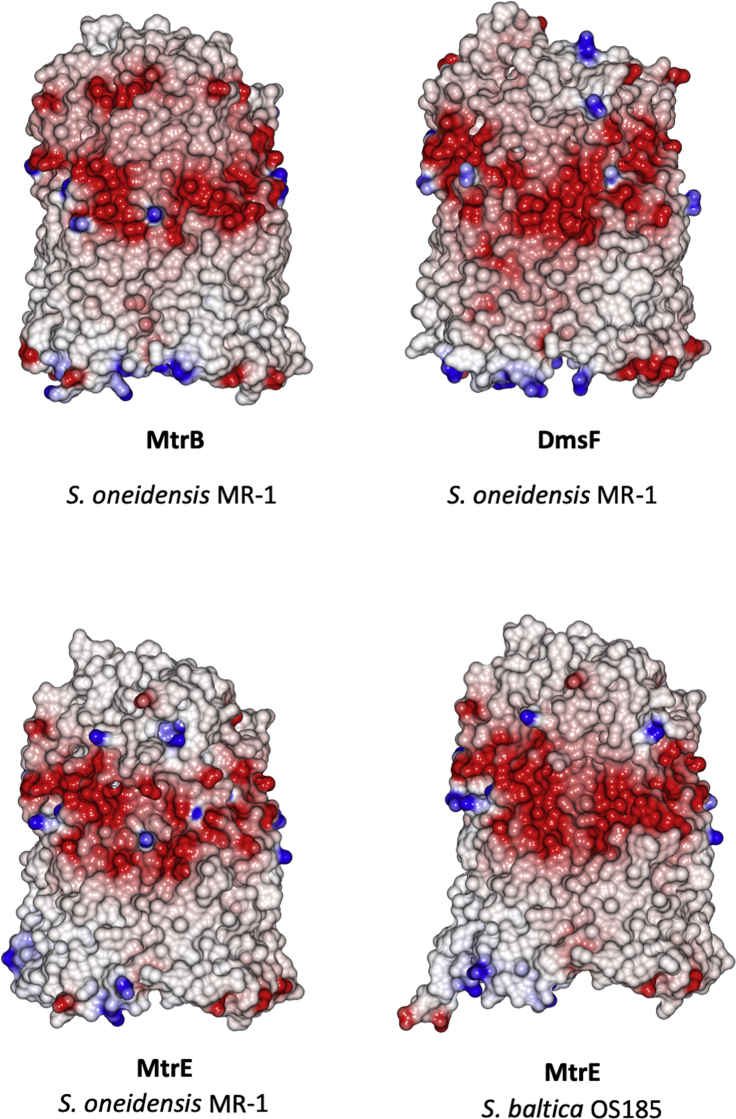
Electrostatic Surface Maps of Molecular Models of MtrB Homologs from S. oneidensis and S. balticaHomology models of MtrB homologs generated using Phyre2 (Kelley et al., 2015) with S. baltica OS185 MtrB as a template. Electrostatic surfaces calculated using CCP4MG with potentials scaled from −0.5 V (red, negatively charged) to +0.5 V (blue, positively charged).